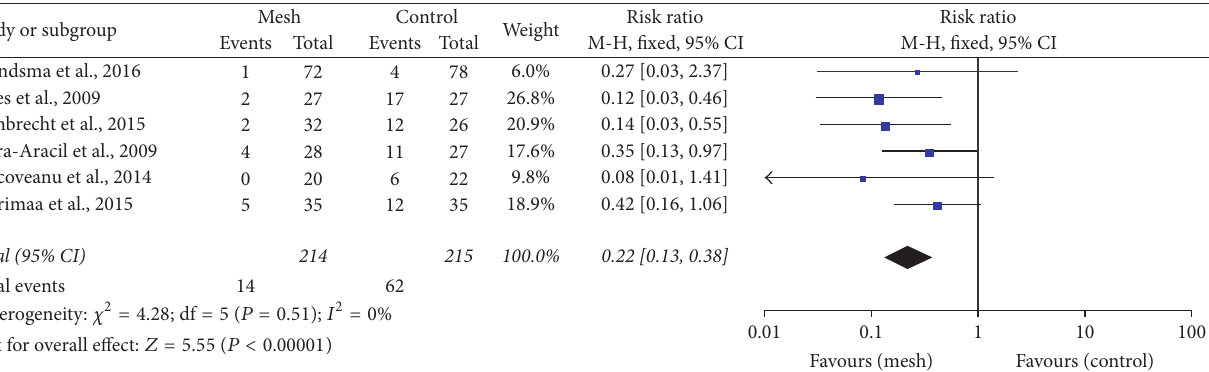
Figure 3: Forest plot for clinically detected parastomal